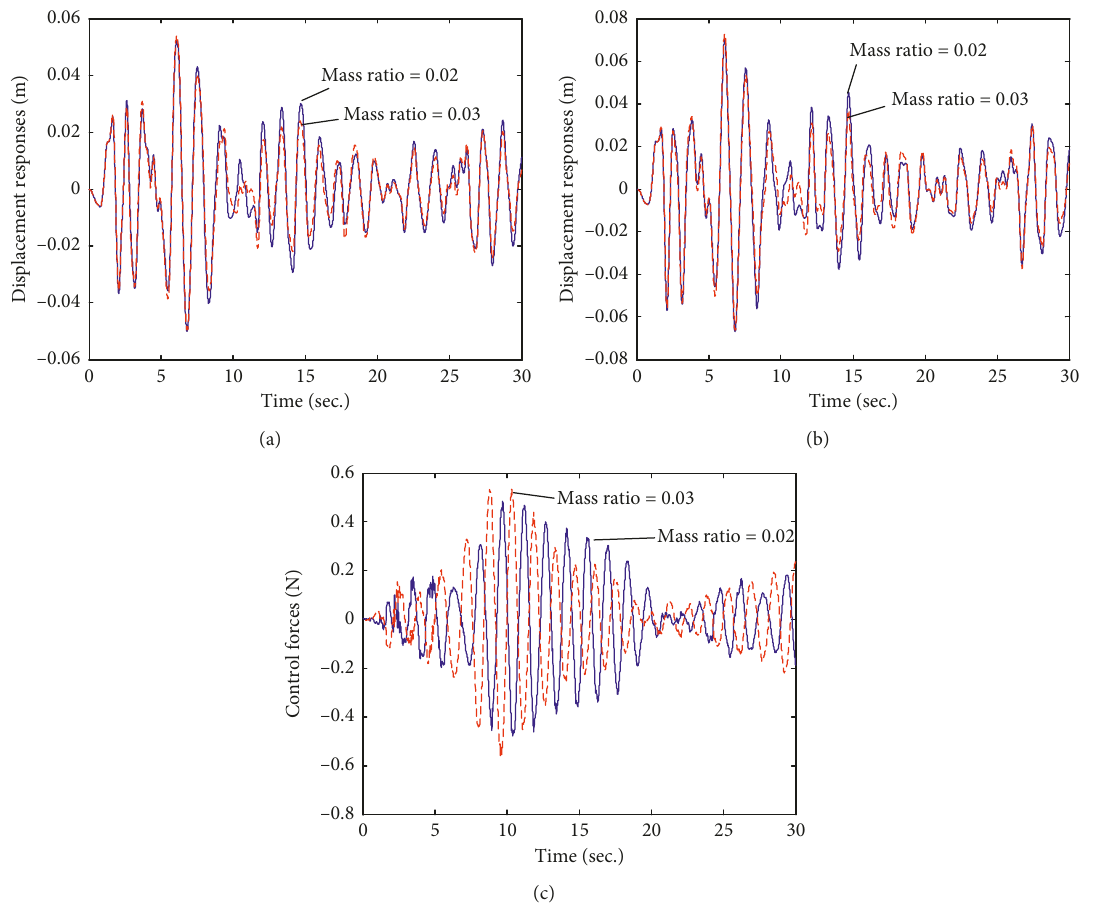
Figure 7: Displacement responses and control forces depending on the mass ratio μ . (a) Dynamic responses (2 nd floor); (b) dynamic responses (3rd floor); (c) control forces at the upper mass of the lever.